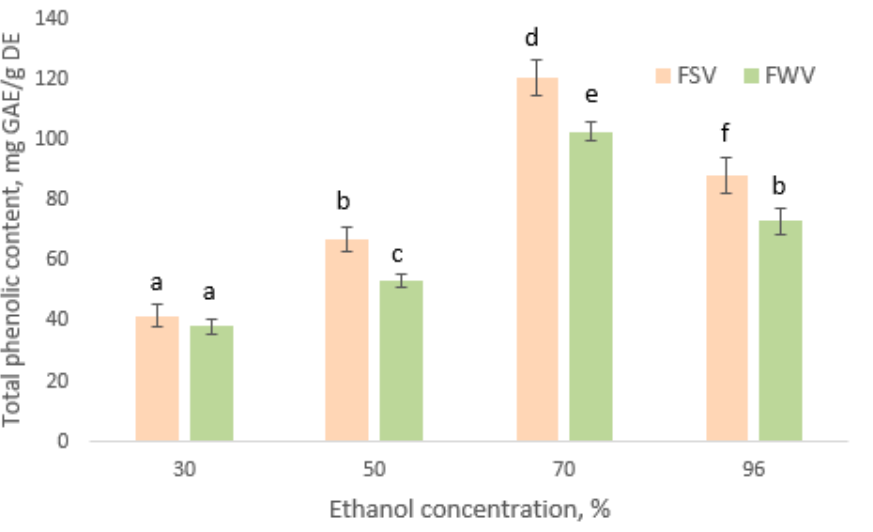
Figure 2. Total phenolic content (mg GAE/g dry extract) in seed extracts of FSV and FWV at different ethanol concentrations. Means not bearing a same letter are significantly different ( p < 0.05).